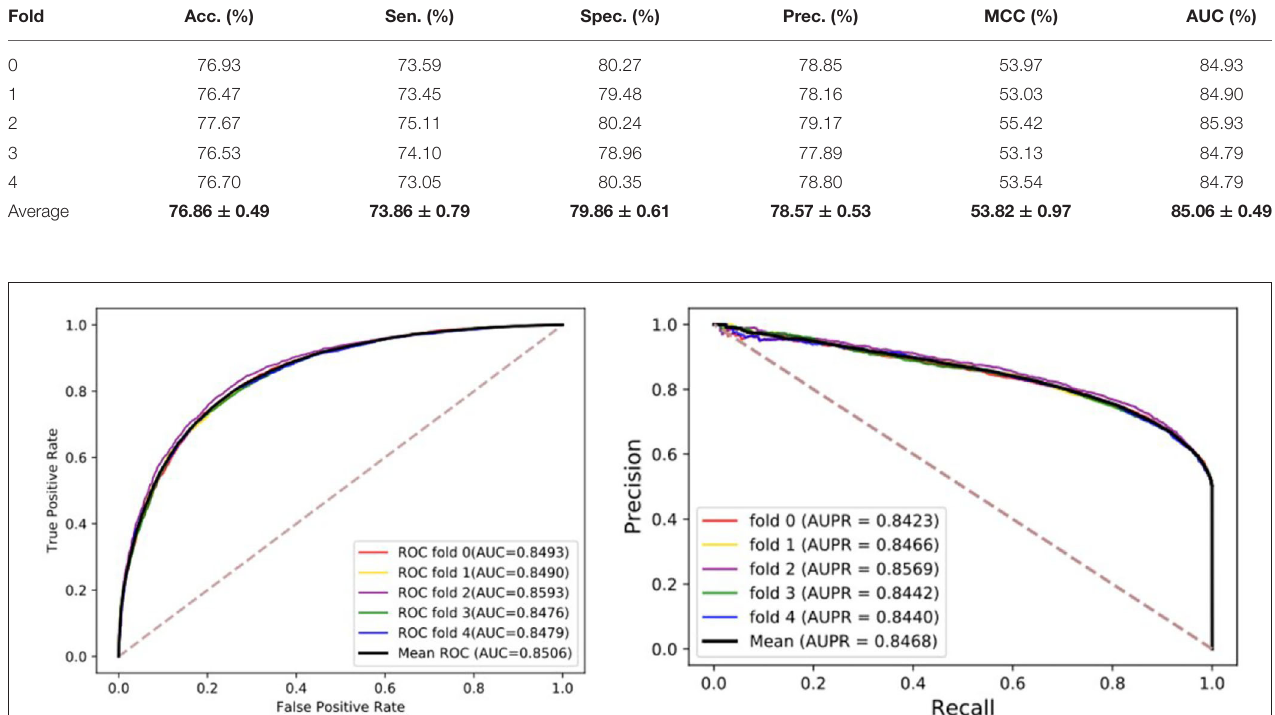
TABLE 1 | Five-fold cross-validation results performed by MGRL.